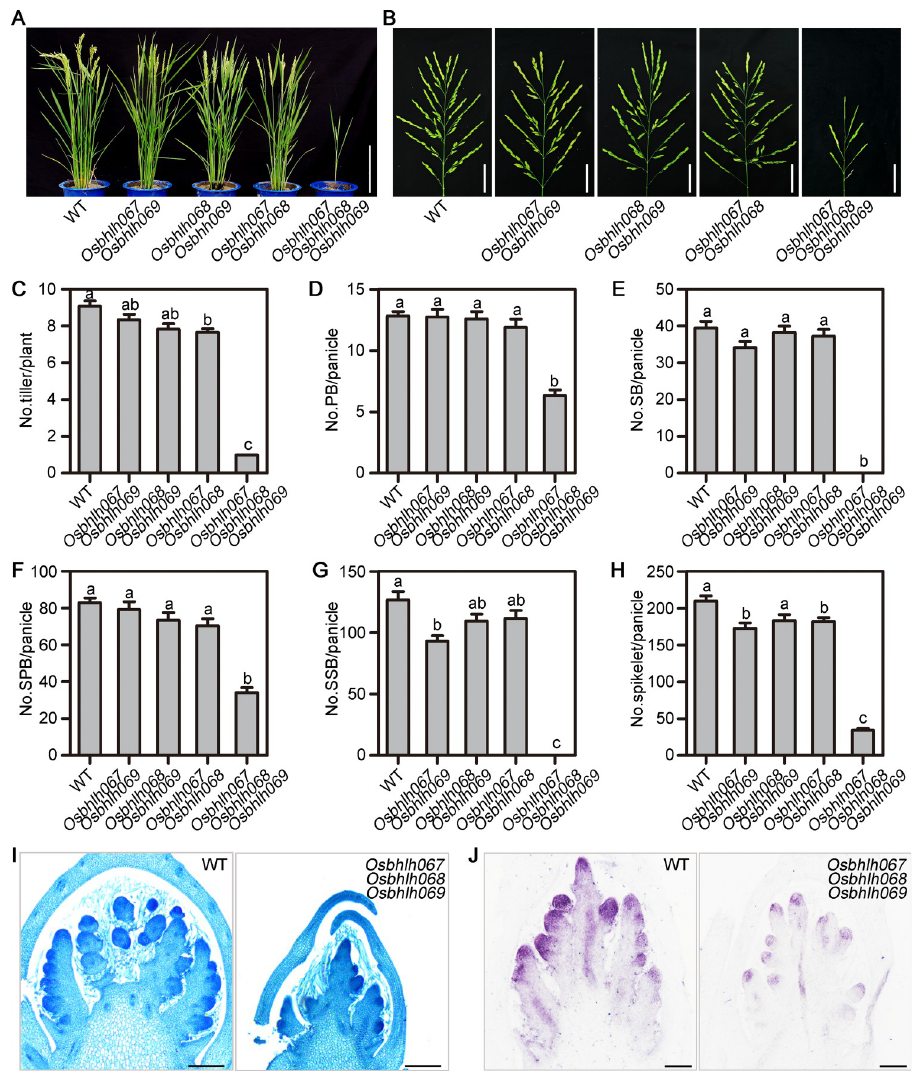
Fig 5. Characterization of double and triple mutants of OsbHLH067 , OsbHLH068 , and OsbHLH069 . (A) and (B) Phenotype comparisons of the plant (A) and panicle (B) for wild type (WT), Osbhlh067 Osbhlh069 , Osbhlh068 Osbhlh069 , and Osbhlh067 Osbhlh068 double mutants, and the Osbhlh067 Osbhlh068 Osbhlh069 triple mutant. Bars = 20 cm in (A) and 4 cm in (B). (C) to (H) Quantification of the number of (C) tillers, (D) primary branches (PBs), (E) secondary branches (SBs), (F) spikelets in PBs (SPBs), (G) spikelets in SBs (SSBs) and (H) total spikelets per panicle in WT, Osbhlh067 Osbhlh069 , Osbhlh068 Osbhlh069 , and Osbhlh067 Osbhlh068 double mutants, and the Osbhlh067 Osbhlh068 Osbhlh069 triple mutant. Data are the means ± SEM from 12 replicates. Different letters denote significant differences ranked by the Dunnett’s test (one-way analysis of variance, P < 0.05). (I) Paraffin sections of inflorescences with SB primordia from WT and the Osbhlh067 Osbhlh068 Osbhlh069 triple mutant. Bars = 100 μ m. (J) In situ localization of OSH1 in WT and Osbhlh067 Osbhlh068 Osbhlh069 triple mutant panicles at the secondary branch primordia differentiation stage. Bars = 100 μ m. slightly increased as indicated by qRT-PCR (S5I Fig). In situ hybridization analysis revealed that the accumulation of LAX1 mRNA was not affected in the few AMs of the triple mutant (S5J–S5L Fig). These results indicated that OsbHLH067/068/069 and LAX1 have no significant mutual effect at the transcriptional level.